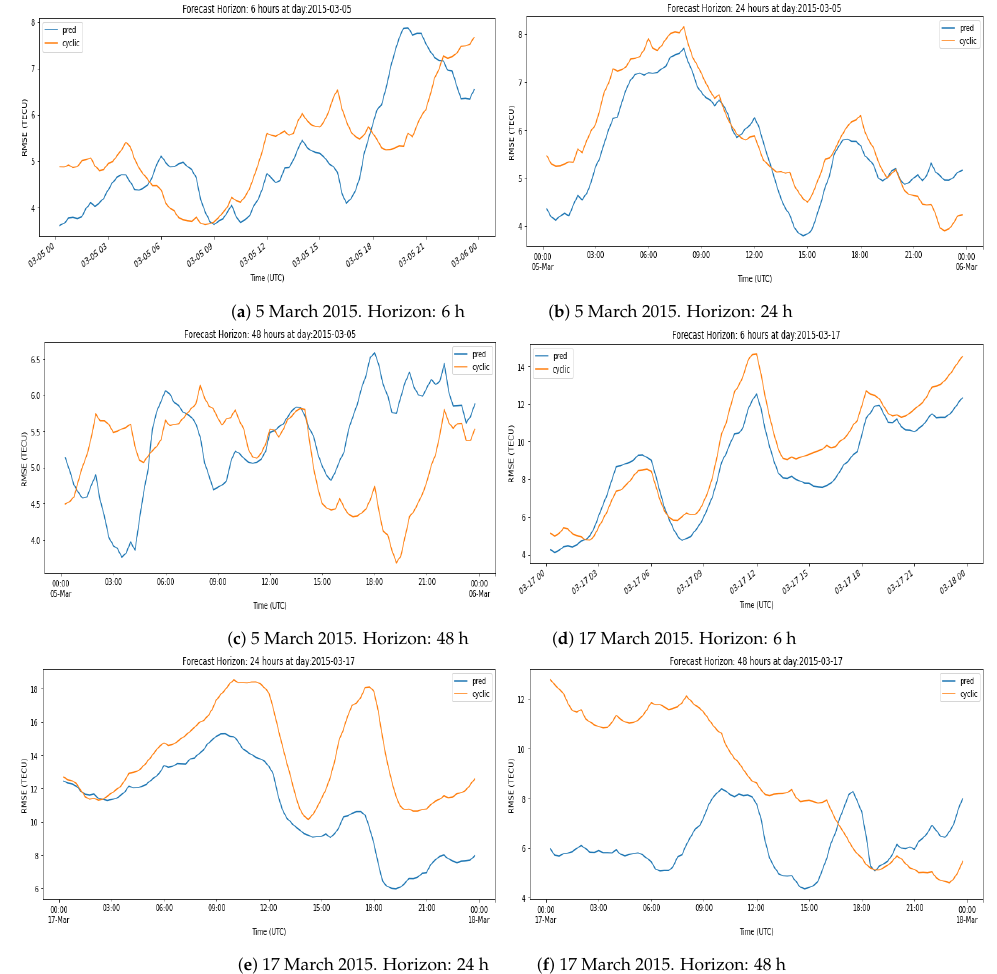
Figure 8. Comparison of the NNGIM forecast vs. frozen cyclic RMSE. Upper row: 5 March 2015 (12 days before the storm). Lower row: 17 March 2015 (the St.Patrick storm